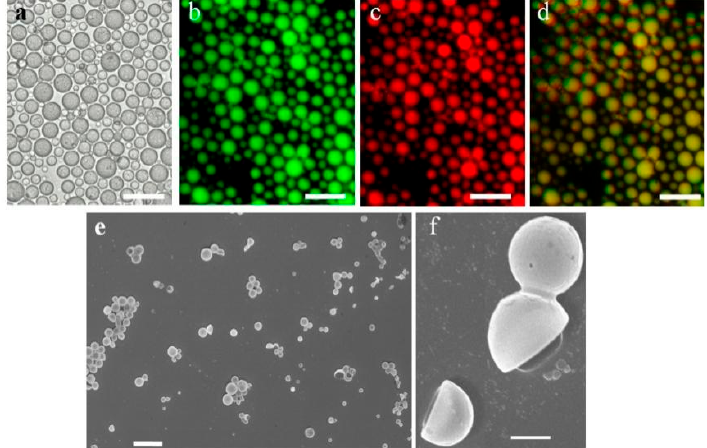
Figure 1. ( a ) Optical microscope image of polymeric microcapsules (HPs) in oil phase, ( b – d ) fluorescence microscope images of HPs in water-in-oil solution, showing ( b ) green and ( c ) red fluorescence derived from encapsulating fluorescein isothiocyanate labeled dextran (FITC-Dextran, MW 500 kDa) and Au NCs, respectively; ( d ) the overlapping image of ( b , c ); and SEM showing a hollow ( e ) and stabilized structure ( f ) of HPs. Scale bars in ( a – d ) are 50 µm, ( e , f ) are 20 µm and 2 µm, respectively.